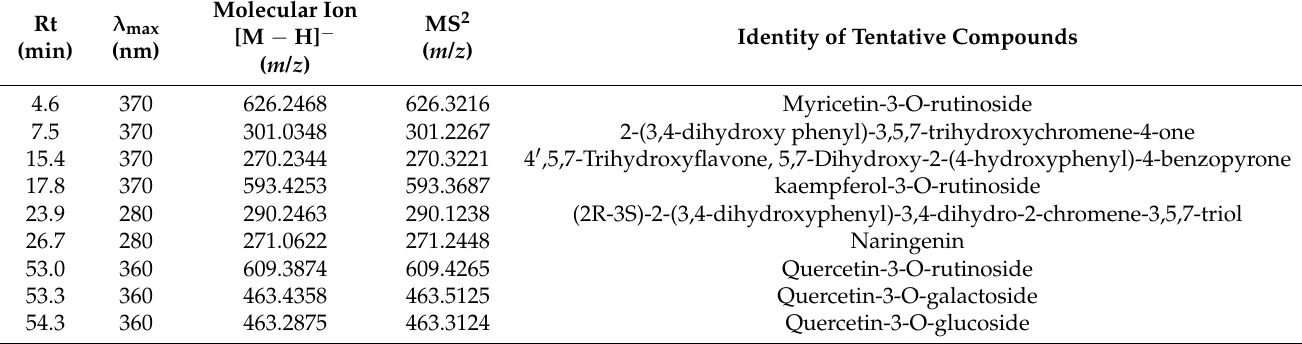
Table 1. Retention time (Rt), wavelengths of maximum absorption in the visible region ( λ max ), mass spectral data, and tentative identification of polyphenolic compounds in